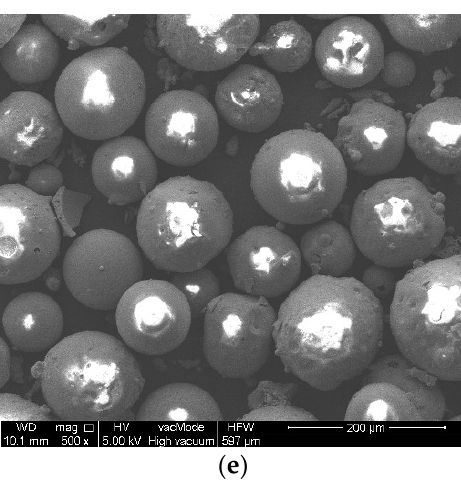
Figure 1. SEM microscope images for the applied powders: ( a ) copper; ( b ) quartz sand; ( c ) Al 2 O 3 ; ( d ) aluminum; ( e ) crystalline silica; and ( f ) microballoon. Each powder is characterized by both a different shape and grain size. Grain size measurements were obtained using SEM and are shown in Figure 2.